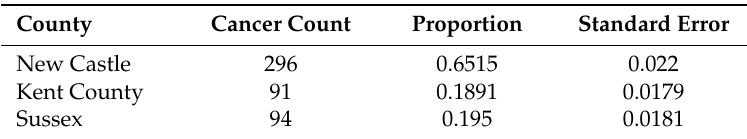
Table 1. Proportion of pediatric malignancies in the three counties of Delaware relative to the state of Delaware.